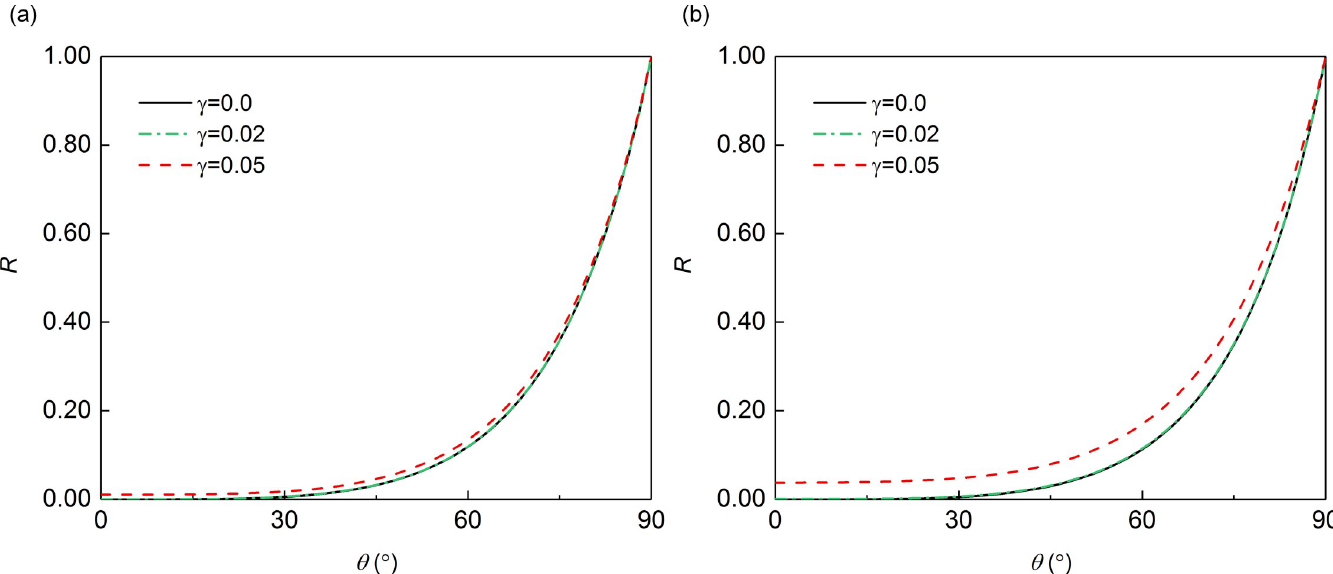
Fig 4. Reflection coefficient in case B : (a) Δ t / T = 1/10 ; (b) Δ t / T = 1/20 .